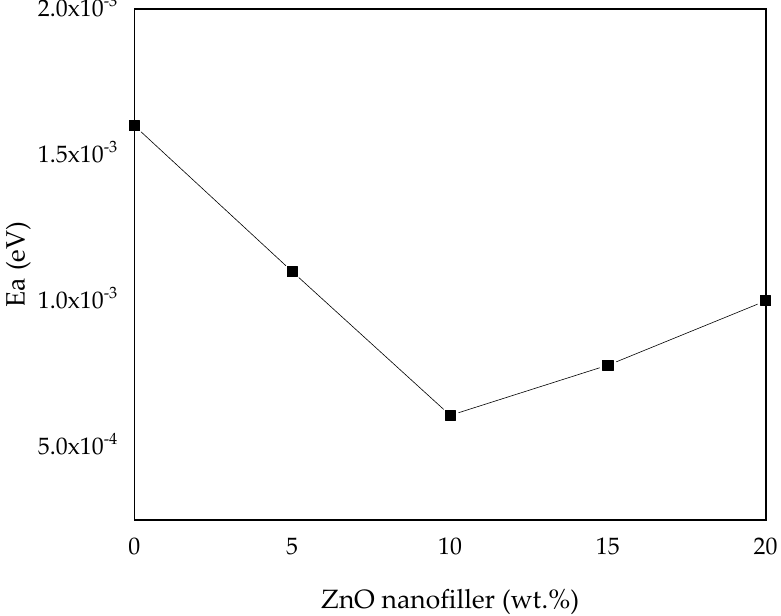
Figure 10. Activation energy (E a ) versus ZnO-NP concentration. Table 4. Activation energy ( E a ) of the prepared SPEs based on PVA–CA–K 2 CO 3 /ZnO-NPs .